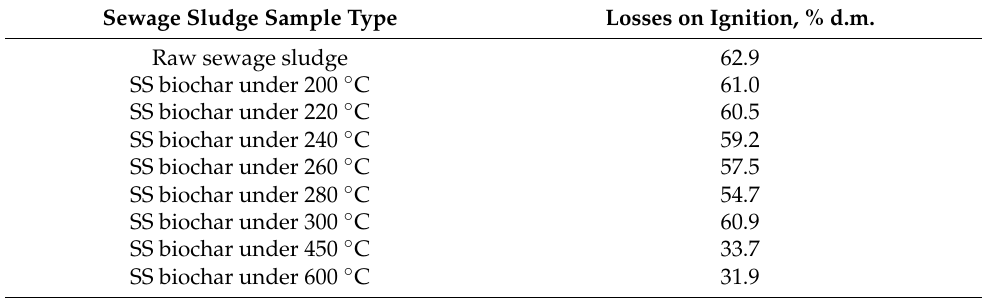
Table 1. The losses on ignition of raw SS and biochars samples produced from SS under different temperatures.